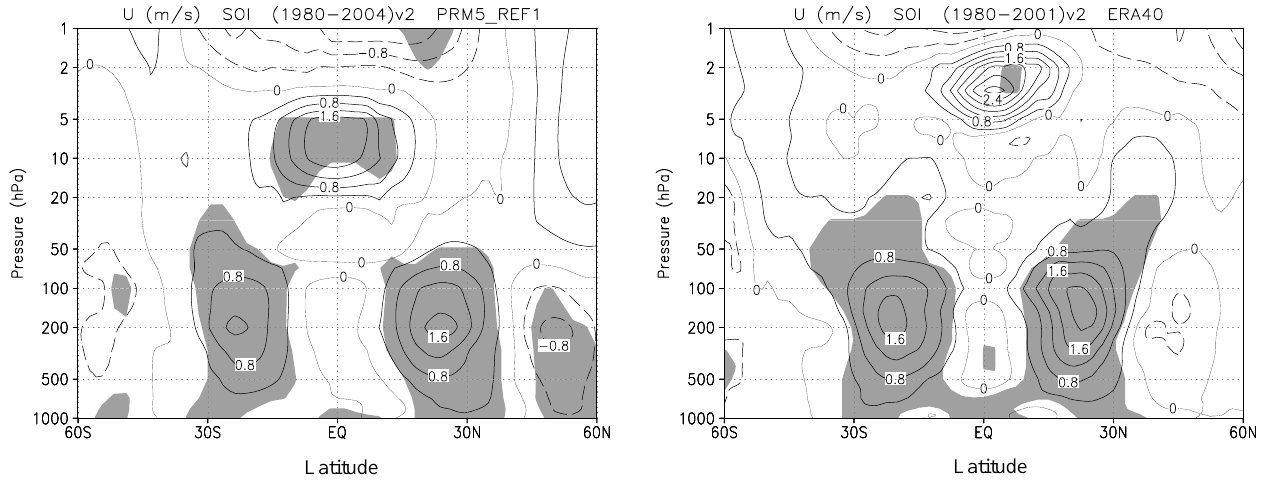
Latitude Latitude Fig. 21. Same as in Fig. 20 except for zonal wind in m/s, and contour interval is 0.4. Fig. 21 Same as in Fig. 20 except for zonal wind in m/s, and contour interval is 0.4.